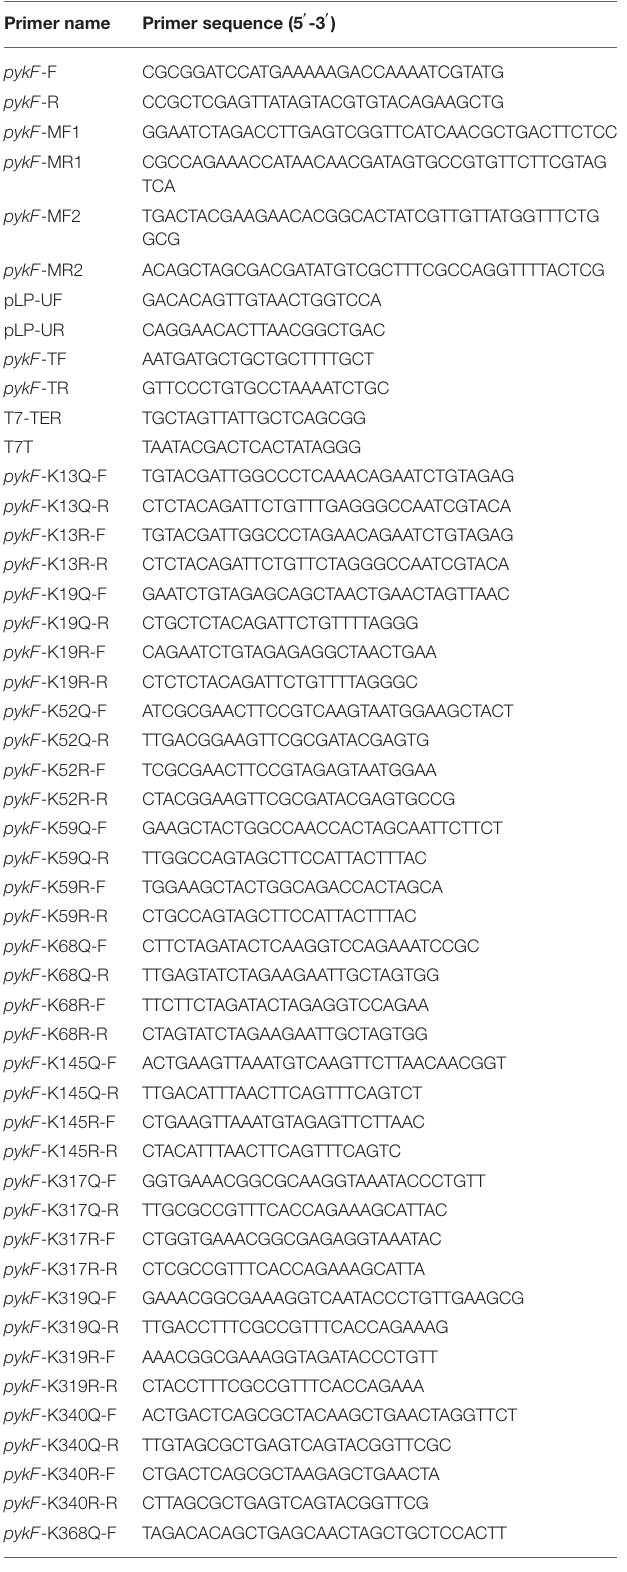
TABLE 2 | Sequences of primers used in this